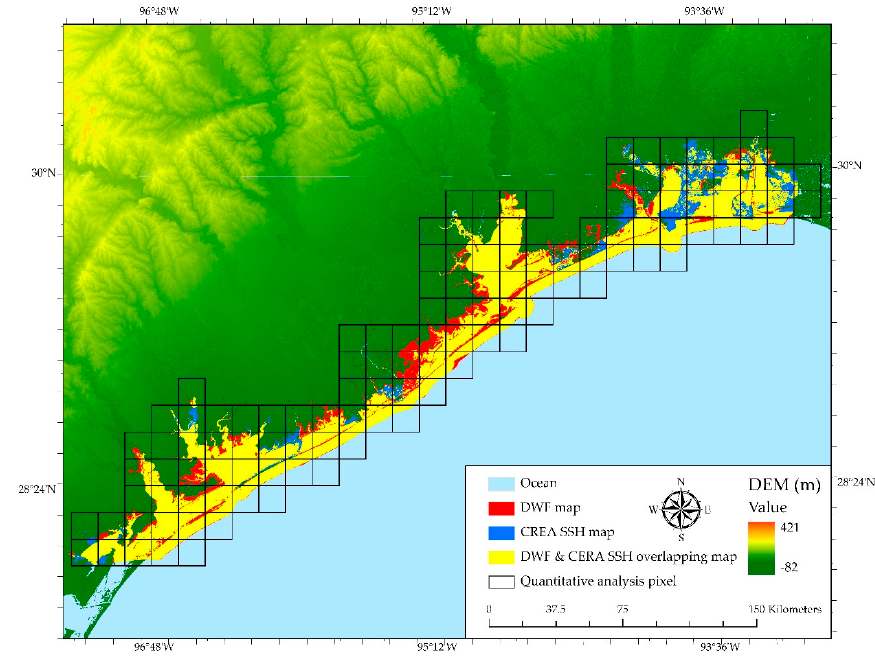
Figure 8. 15 × 15 km comparison grid (black), DWF map (red), CREA SSH product (blue) and Figure 8. 15×15 km comparison grid (black), DWF map (red), CREA SSH product (blue) and overlapping areas overlapping areas (yellow).